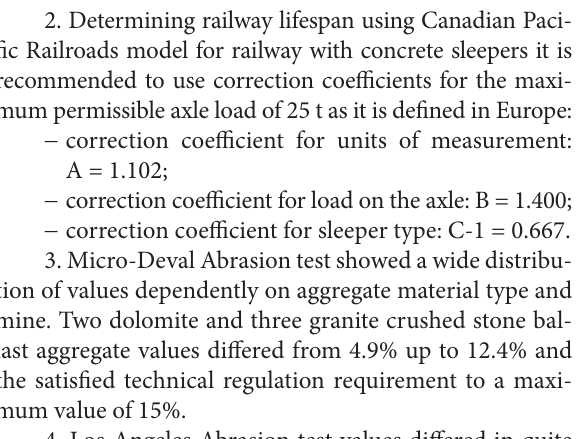
Table 2. Highway rail lines for passenger trains to run at 160 km/h until 200 km/h are assigned to category K-1 of ballast mechanical properties.